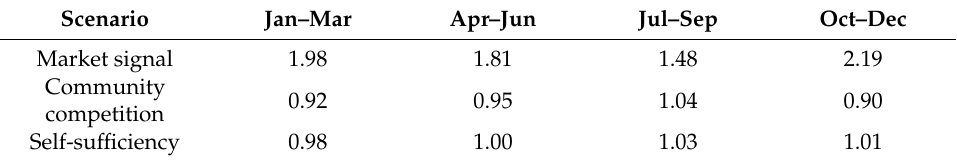
Table A3. Standard deviation of electricity retail prices during different seasons.